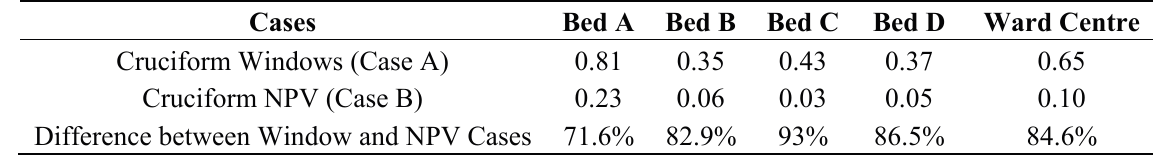
Table 2. The CRE values computed at five locations for all three Cases in Cruciform